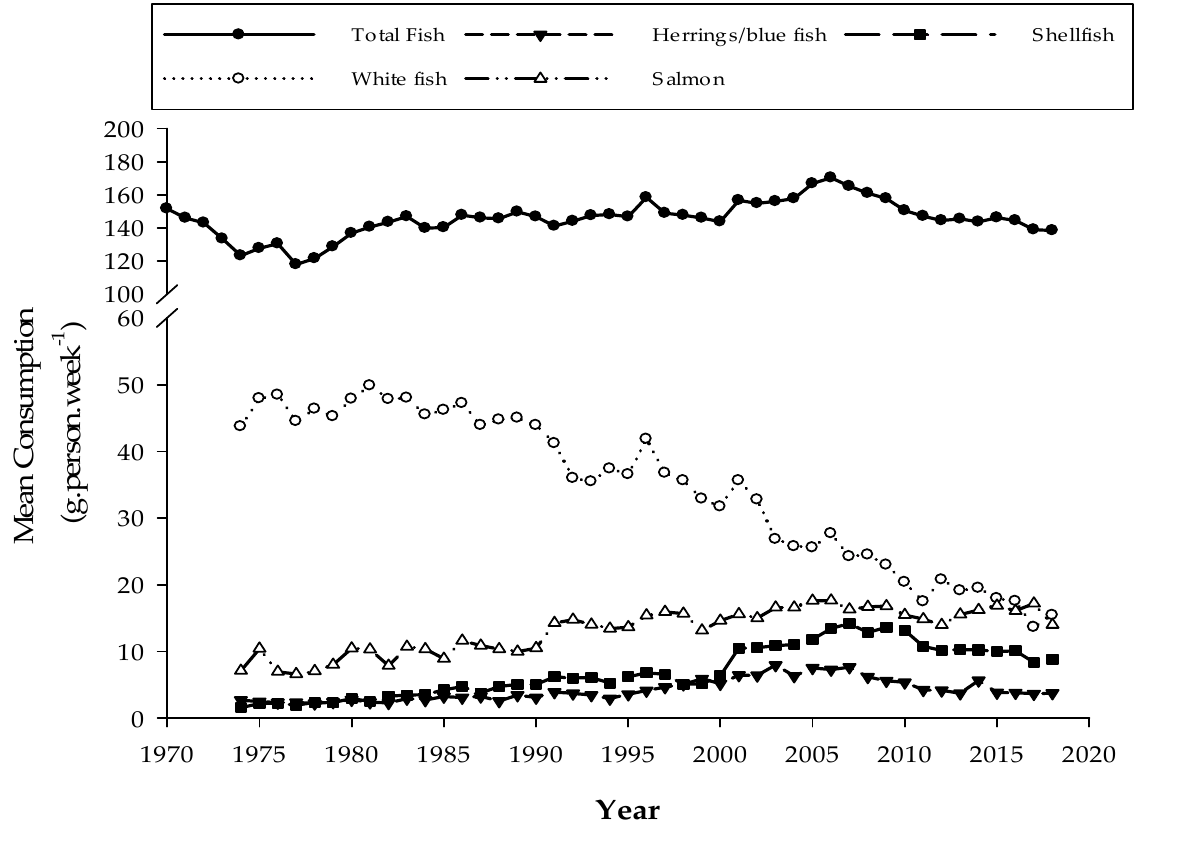
Figure 3. Mean UK consumption (g·person·week −1 ) of total fish ( __ ● __ ) and breakdown of major sub- groups: whitefish ( …. ○ …. ), herring/blue fish ( _ _ ▼ _ _ ), salmon ( _.._ ∆ .._.. ), and shellfish ( __ _ ■ _ __ ). Data extrapolated from the UK’s Family Food datasets 2018/19 [74].